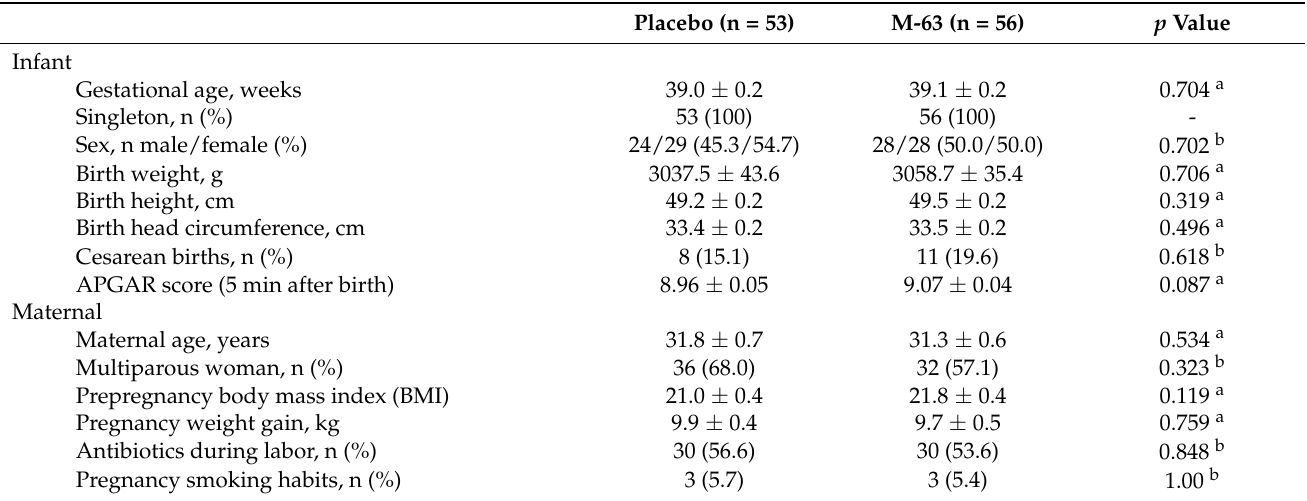
Table 1. Subject background of infants and